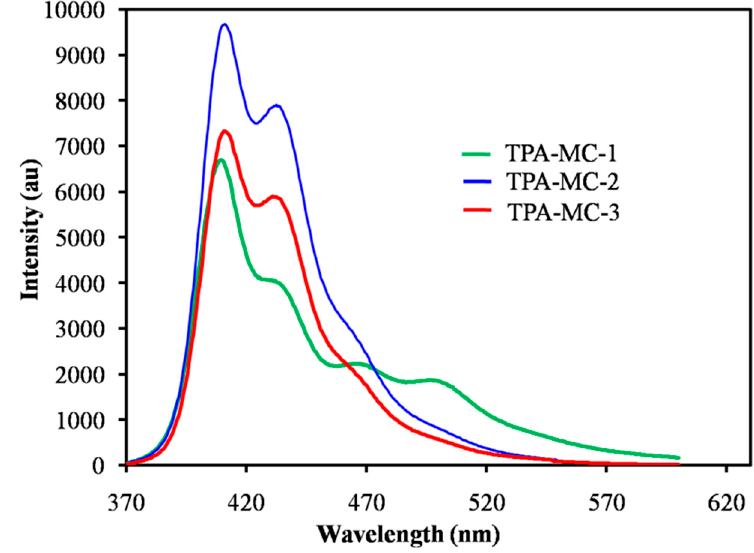
Figure 3. Fluorescence emission spectra of TPA-MC-1, TPA-MC-2, and TPA-MC-3 in chloroform solution ( λ ex = 350 nm).